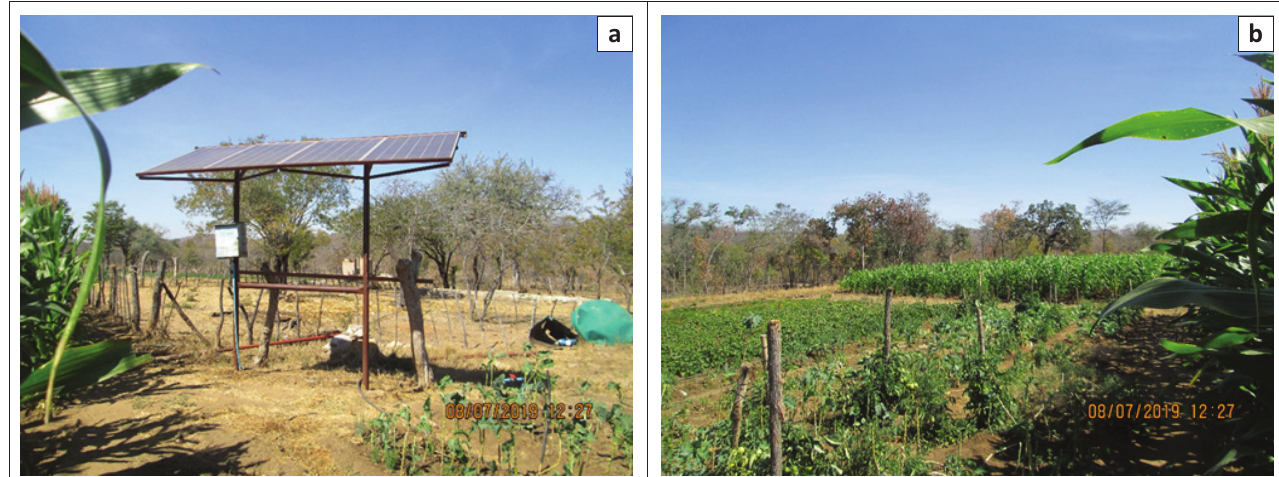
FIGURE 3: (a and b) A submersible solar-powered borehole irrigation system in